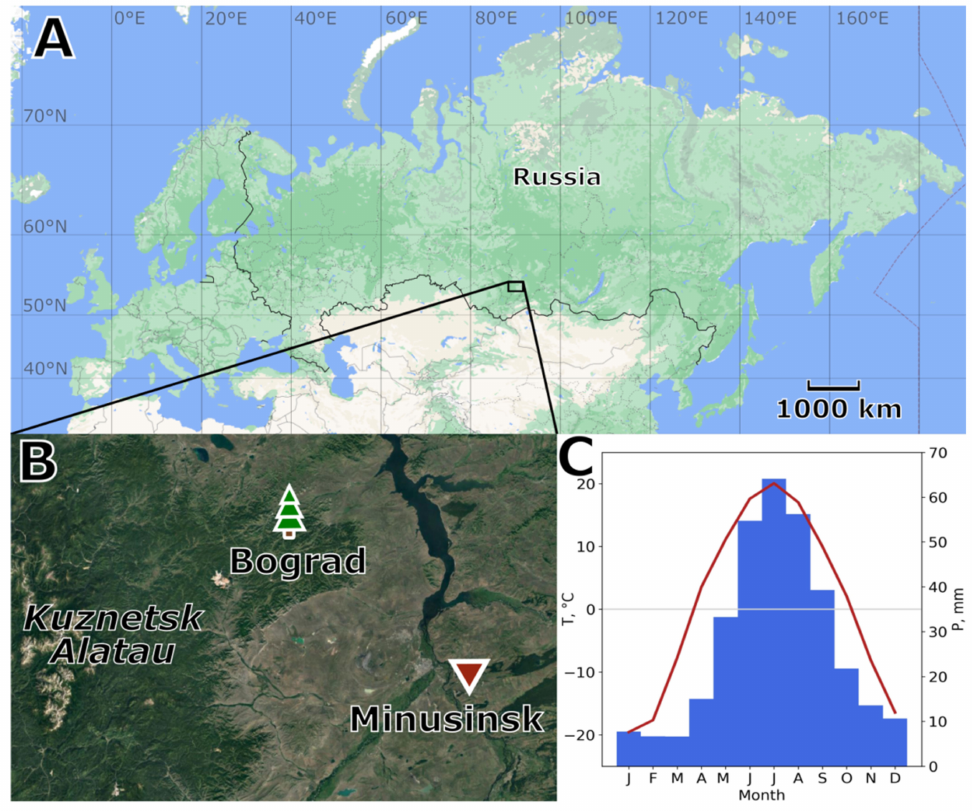
Figure 1. The locations of the study plot (green tree) and climate station (red triangle) ( A , B ), and the average monthly mean temperature ( ◦ C) and monthly total precipitation (mm) over the years 1917–2018 ( C